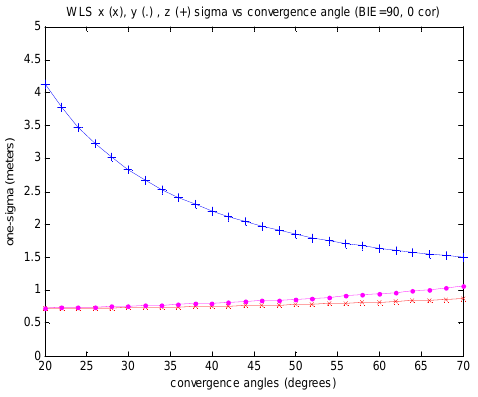
Figure 5. Sigma-x, sigma-y, sigma-z vs. convergence angle